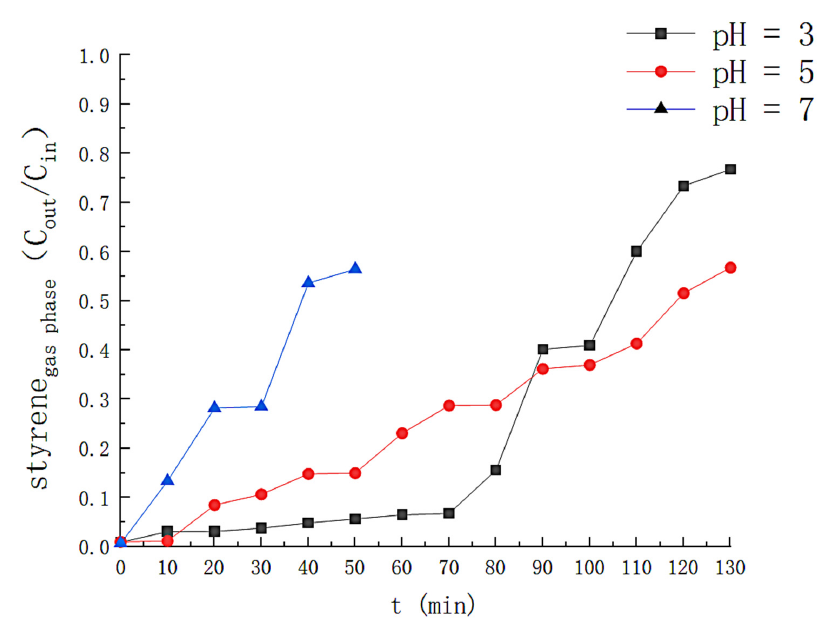
Figure 4. Effect of different pH on the removal efficiency of styrene.